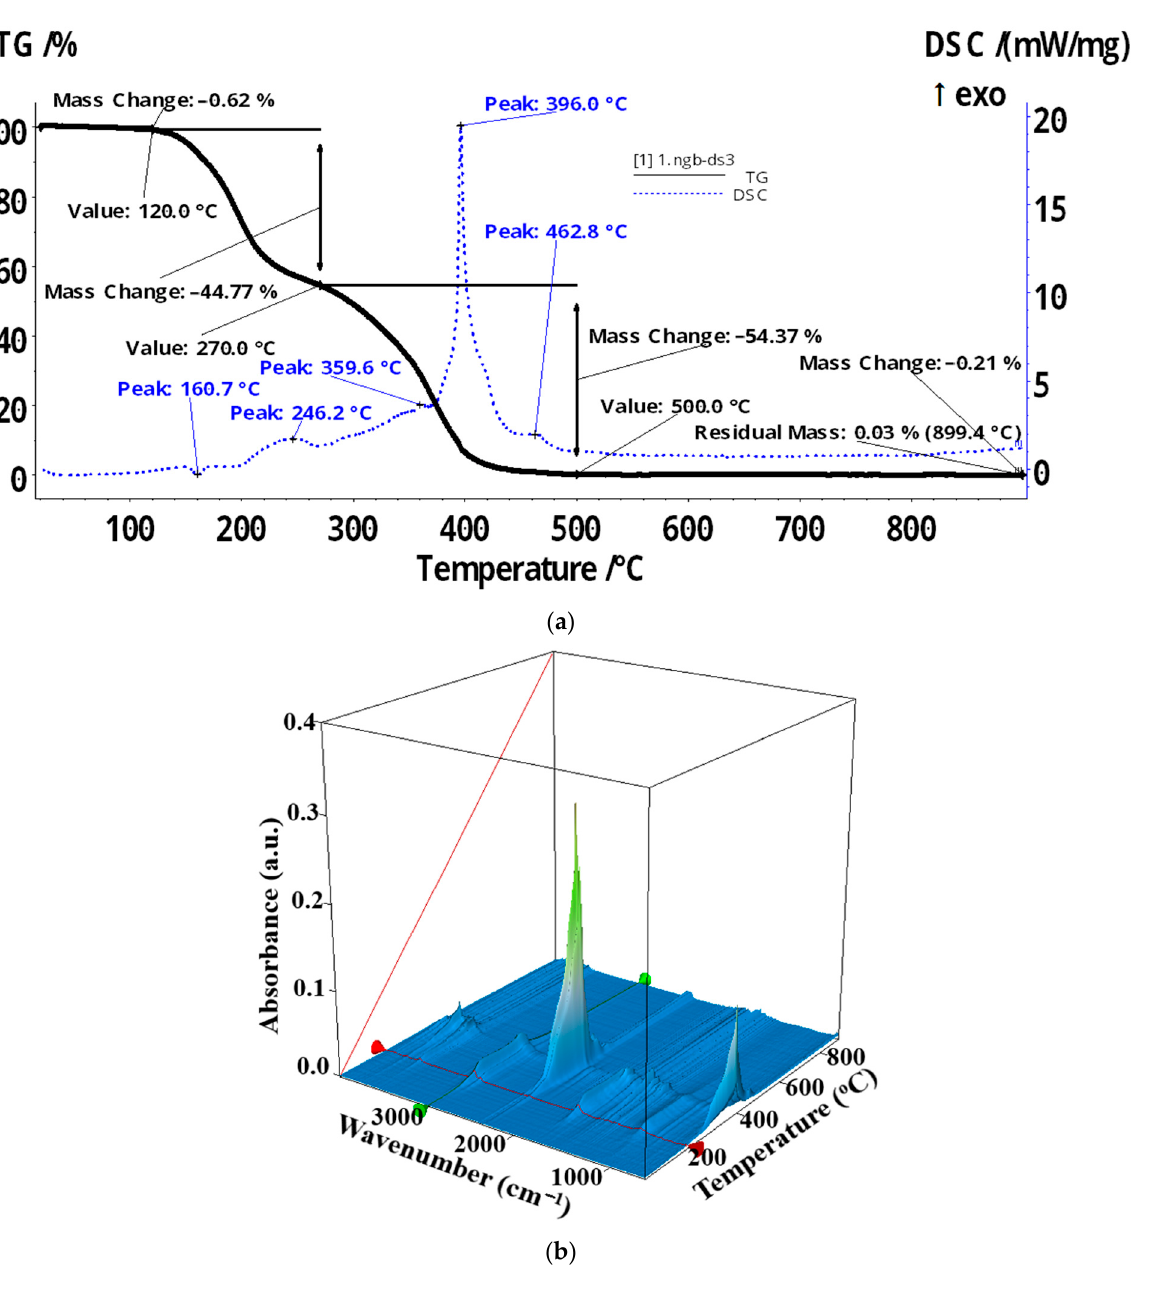
Figure 10. Thermal characteristics ( a ) and the 3D plot of FTIR spectrum vs. temperature ( b ) for the evolved gases from the Os–PPM p sample.